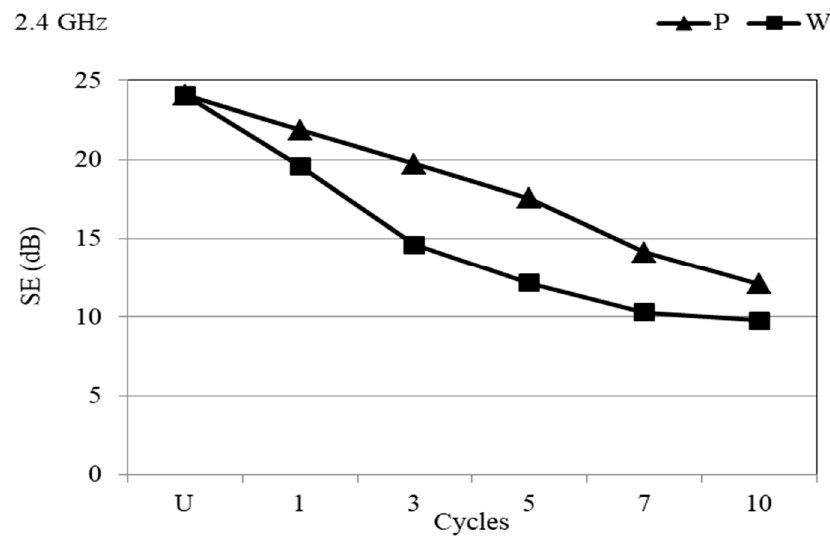
Figure 10. SE of the PA/Ag fabric before and after 10 cycles of treatment with P and W at the frequency of 2.4 GHz.